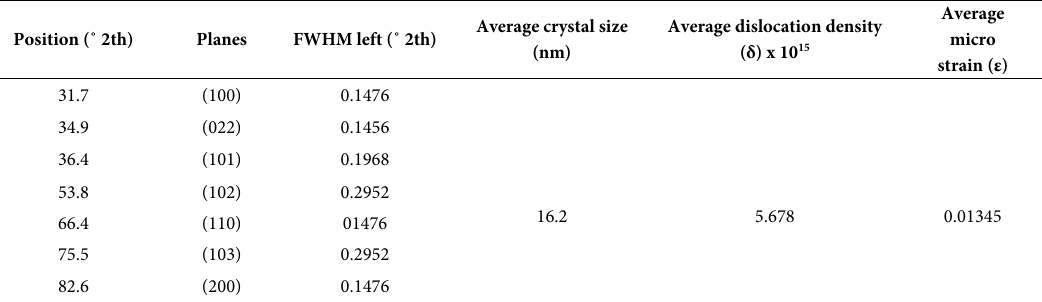
Position (˚ 2th) Planes FWHM left (˚ 2th)